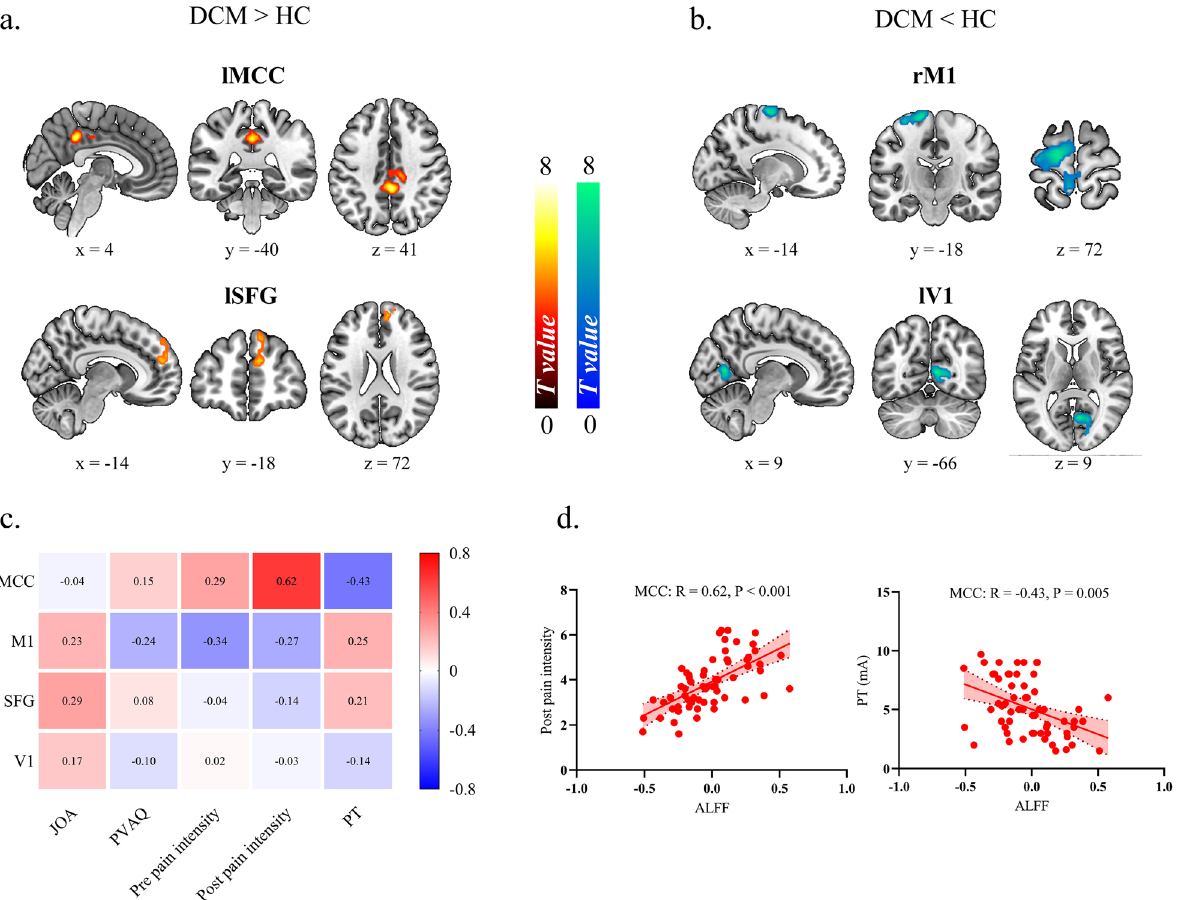
Fig. 3 Analysis of Amplitude of Low Frequency Fluctuation (ALFF) alterations and its relationship to clinical metrics in Degenerative Cervical Myelopathy (DCM) patients. a The increased ALFF in DCM patients. lMCC: left Middle Cingulate Cortex; lSFG: left Superior Frontal Gyrus; b The